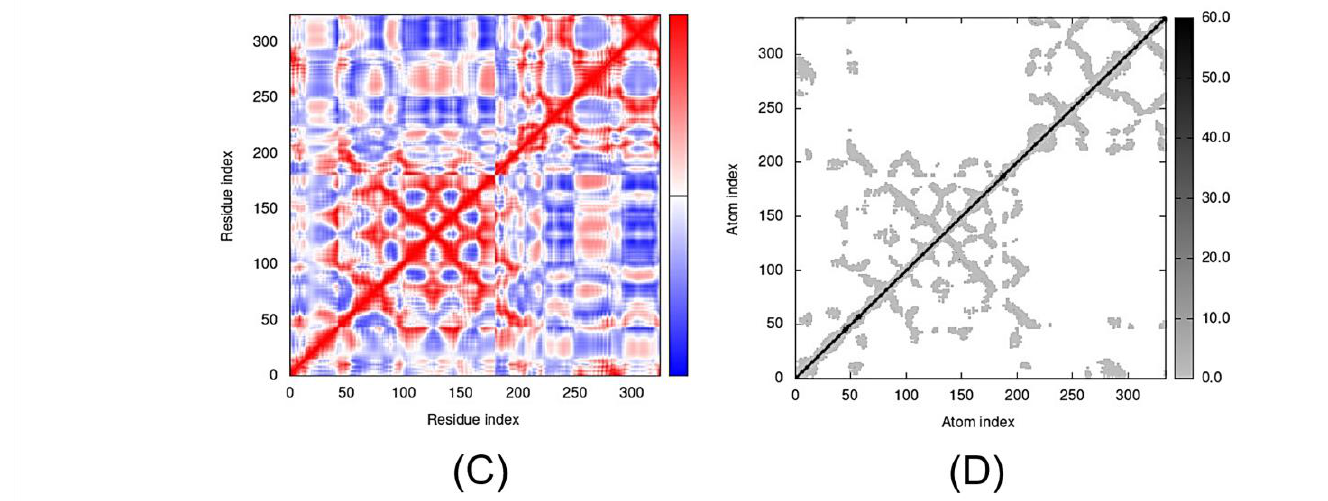
Figure 7. Outputs of molecular dynamics simulations through iMODS for GDF1-TMZ: ( A ) deformability and B-factor plot; ( B ) eigenvalue and variance plot; ( C ) elastic network model; and ( D ) covariance map.